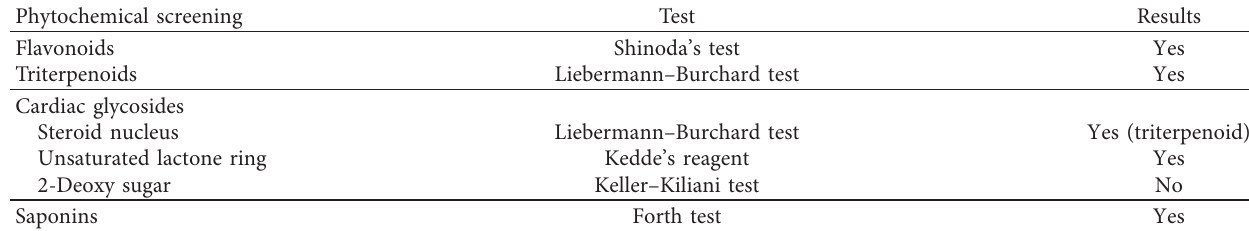
Table 1: Phytochemical screening of the SA extract.